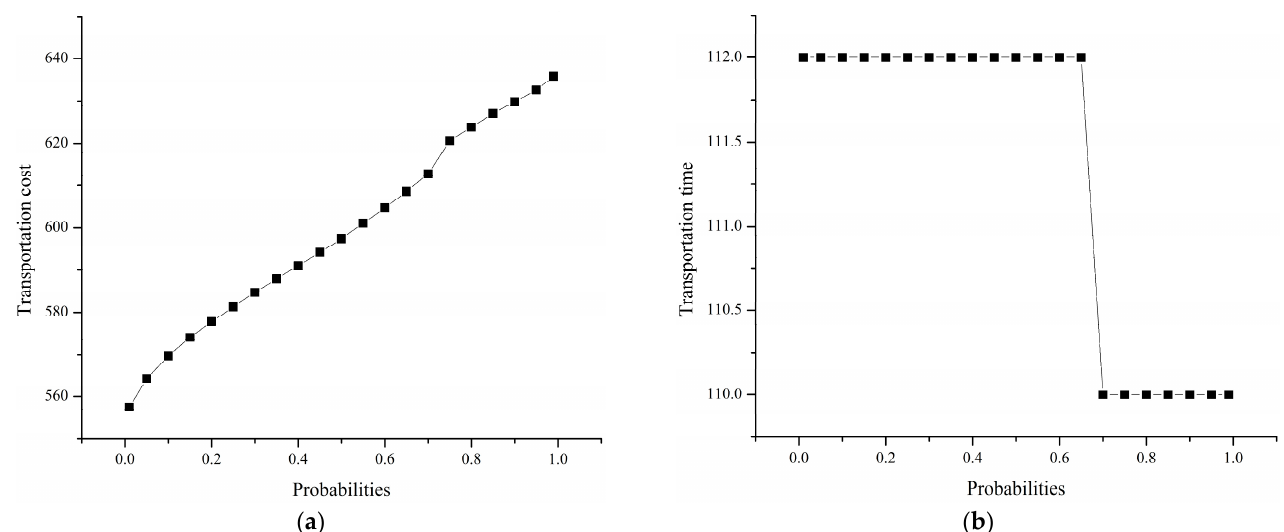
Figure 3. Sensitivity analysis of the optimal transportation cost ( a ) and time ( b ) concerning the probability for demand requirements. Table 8. Sensitivity analysis concerning the probability for 𝑏 (cid:3037) .